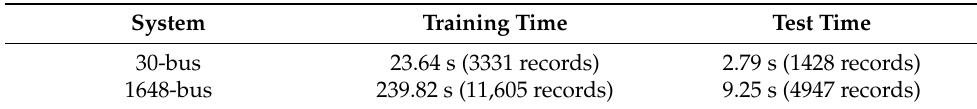
Table 5. Data processing speed tests for the two